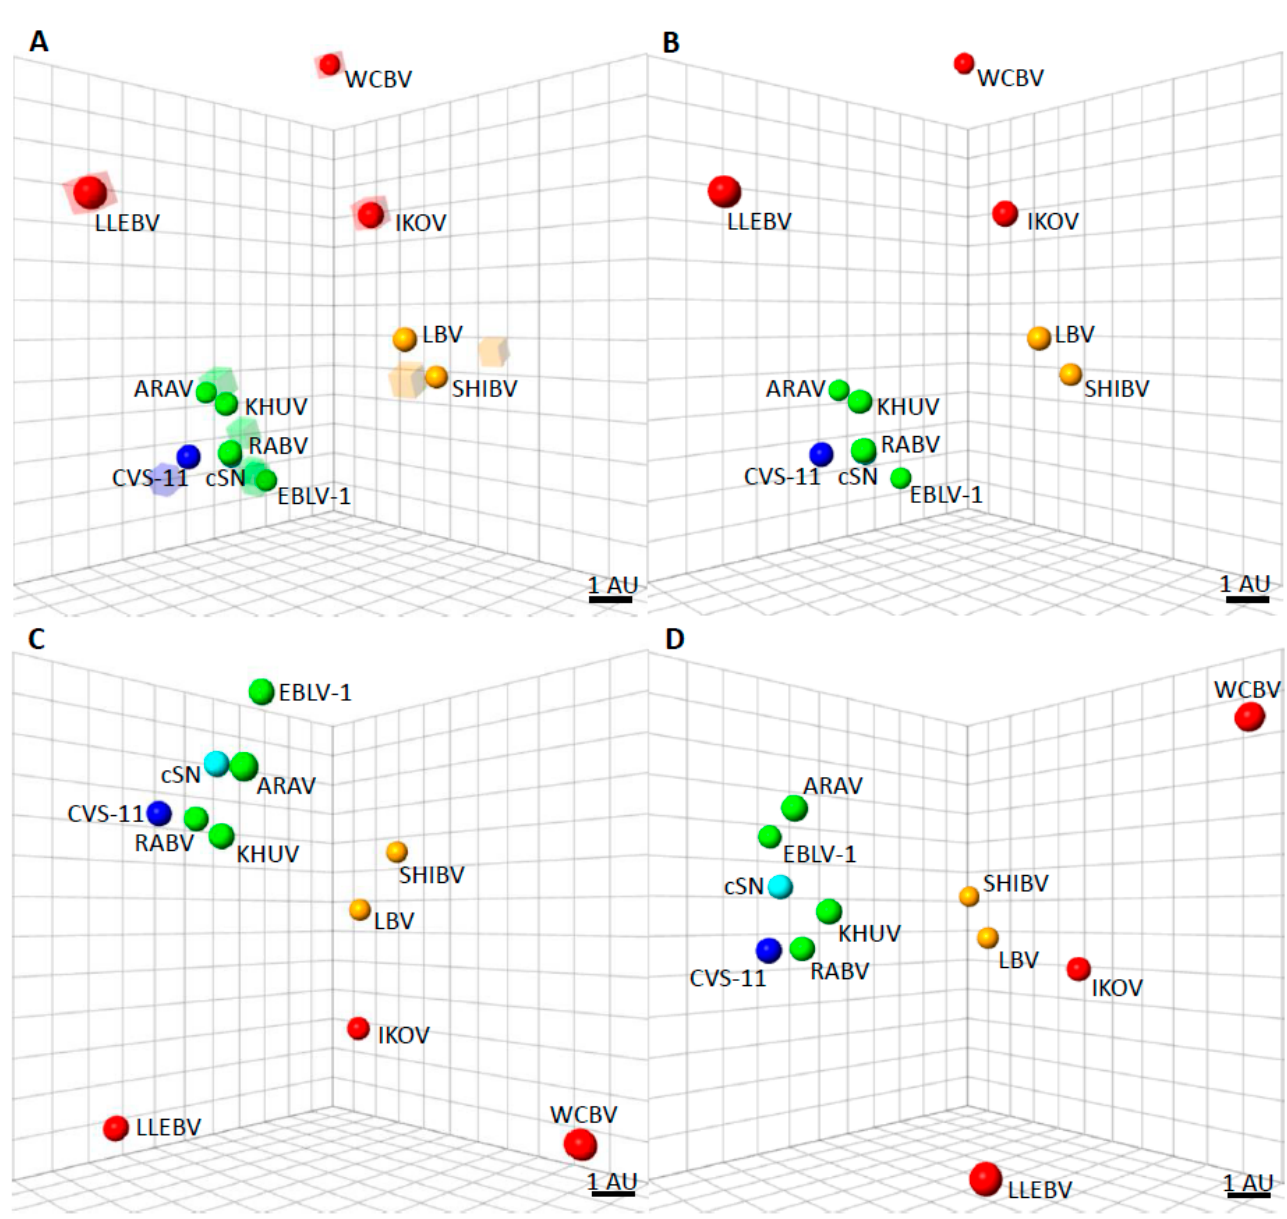
Figure 2 . Antigenic cartography maps to show the antigenic distances of the lyssaviruses. ( A ) Three-dimensional antigenic map showing the antigenic relationship between lyssaviruses. Viruses (spheres) and, sera (translucent coloured boxes) are positioned such that the distance from each serum to each virus is determined by the neutralisation titre. Multidimensional scaling is used to position both sera and viruses relative to each other, so orientation of the map within the axes is free. The scale bar represents 1 AU (antigenic unit), equivalent to a two-fold dilution in antibody titre. Phylogroup I lyssaviruses are coloured green, CVS-11 coloured dark blue [Challenge virus standard-11 strain of RABV, used routinely in diagnostic assays], cSN [cDNA clone of the SN strain of RABV derived from the RABV strain, SAD B19] coloured light blue, Phylogroup II lyssaviruses coloured orange, and Phylogroup III lyssaviruses coloured red. ( B ) Antigenic map with sera removed for clarity. ( C ) Antigenic map, rotated to a different orientation and sera removed for clarity. ( D ) Antigenic map, rotated to a different orientation and sera removed for clarity.